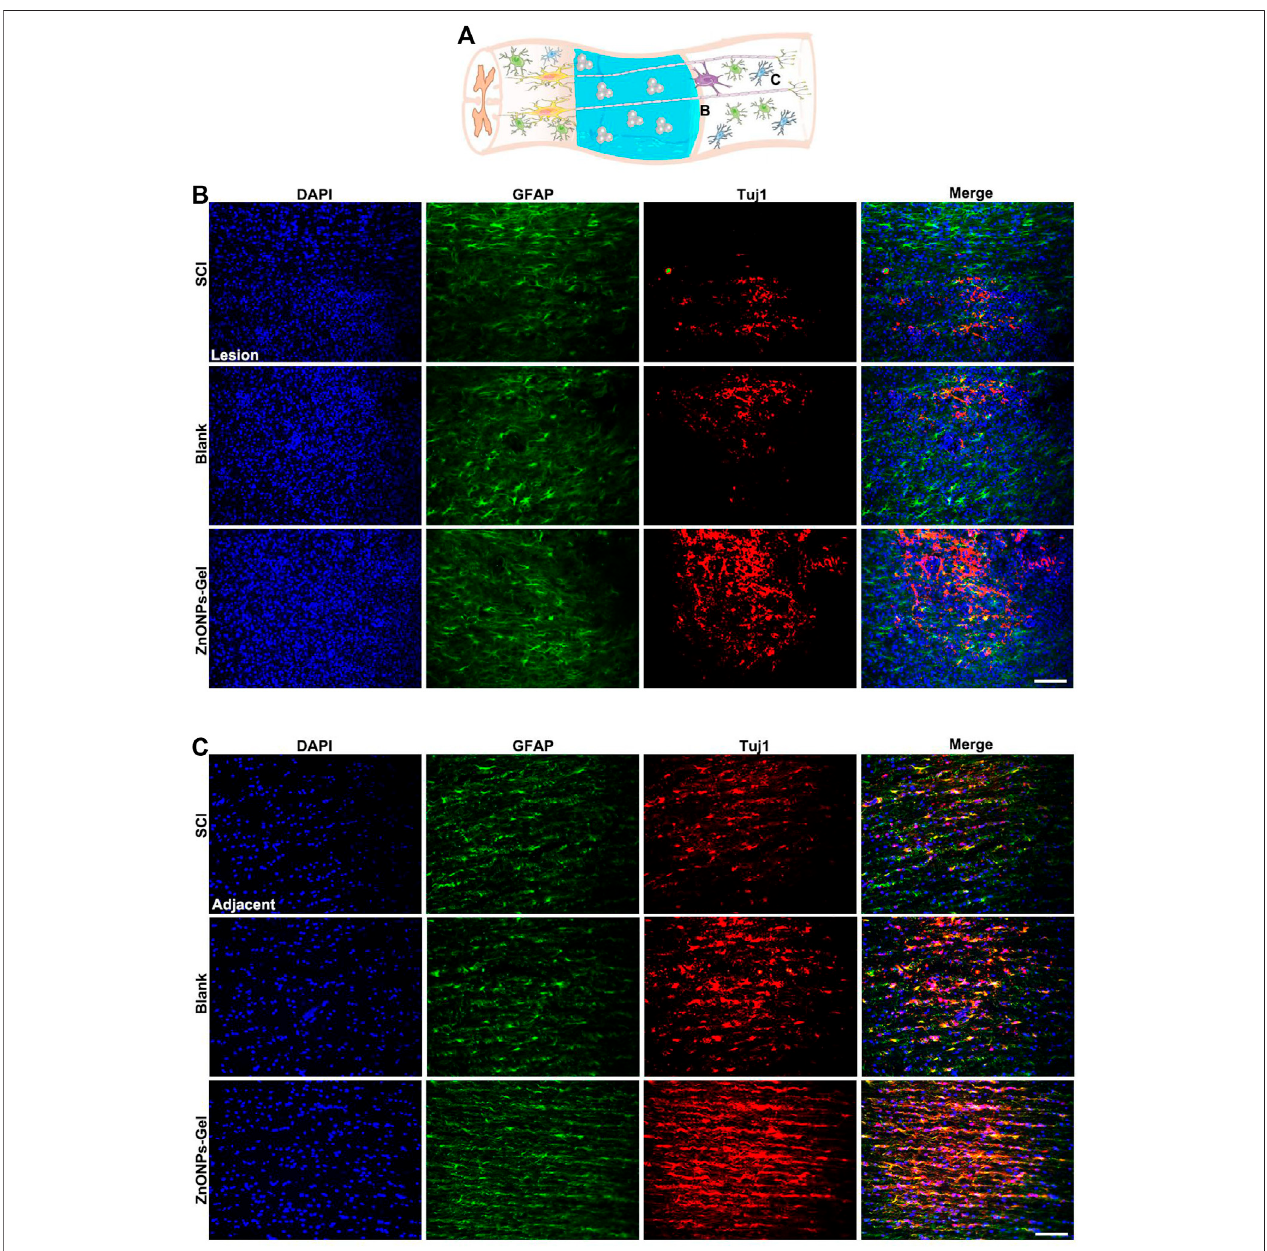
FIGURE3| ZnONPs-Gelimprovedinjuredthespinalcordondays28afterSCI.Modelofinjuredspinalcord (A) .RepresentativeimagesshowingTuj1(red)andglial fi brillary acidic protein (GFAP, green) staining in the lesion (B) and the adjacent (C) of SCI, blank, and ZnONPs-Gel groups. Scale bar (cid:2) 100 μ m. Data are mean ± SD ( n (cid:2)